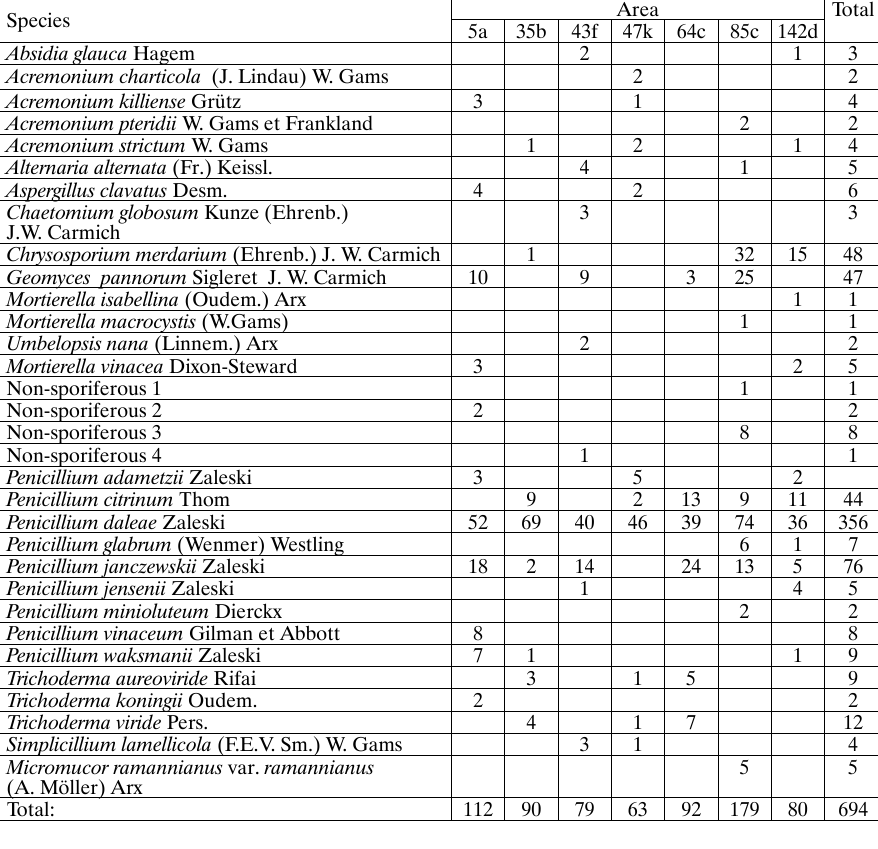
Species of fungi obtained on investigation areas Species